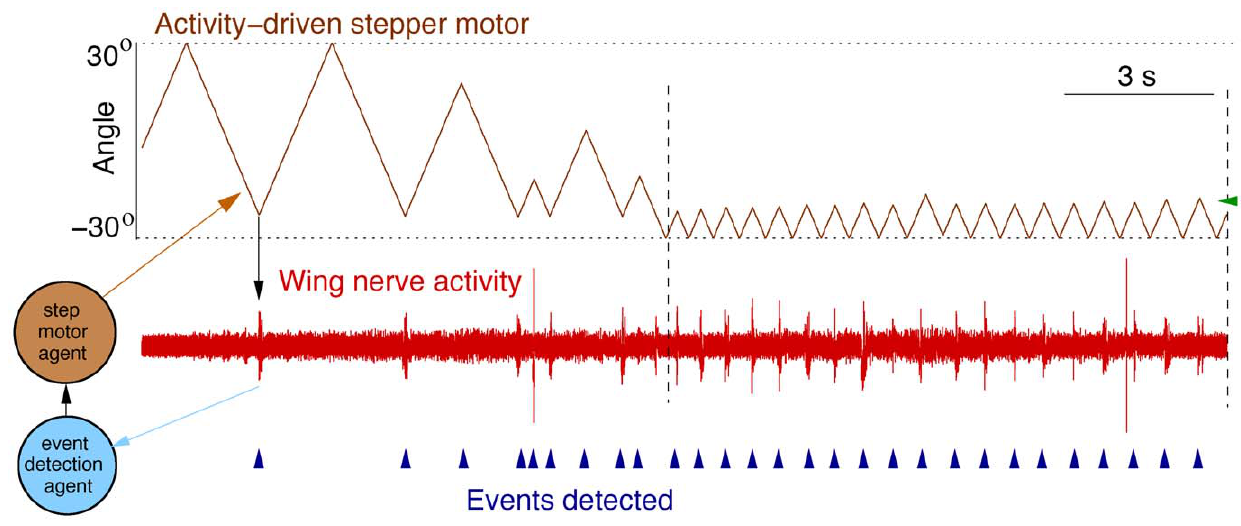
Figure 9. Automatic receptive field search through the stepper motor activity-dependent stimulation. The figure shows the simultaneous recording of the stepper motor movement (top row), the wing motor nerve (middle row) and the real time burst detection on the wing nerve (bottom row). The motor is automatically sweeping through a range of angles. The software monitors the occurrence of stereotyped bursts in the activity of the wing nerve. After a burst detection or when a defined maximum angle is reached (horizontal dotted lines), the motor changes direction. Vertical dashed lines indicate a region where a strong response of wing motoneurons was observed in response to a stimulation around 2 21 u (green horizontal arrow).